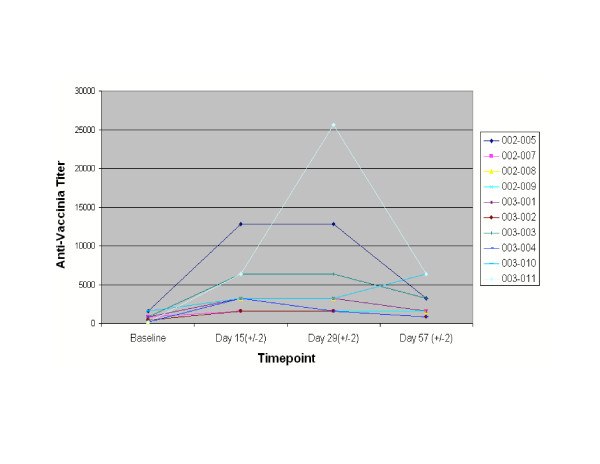
Effect of vaccination on anti-vaccinia antibody response: Antibody titers of patients are shown for baseline and days 15, 29, and 57.